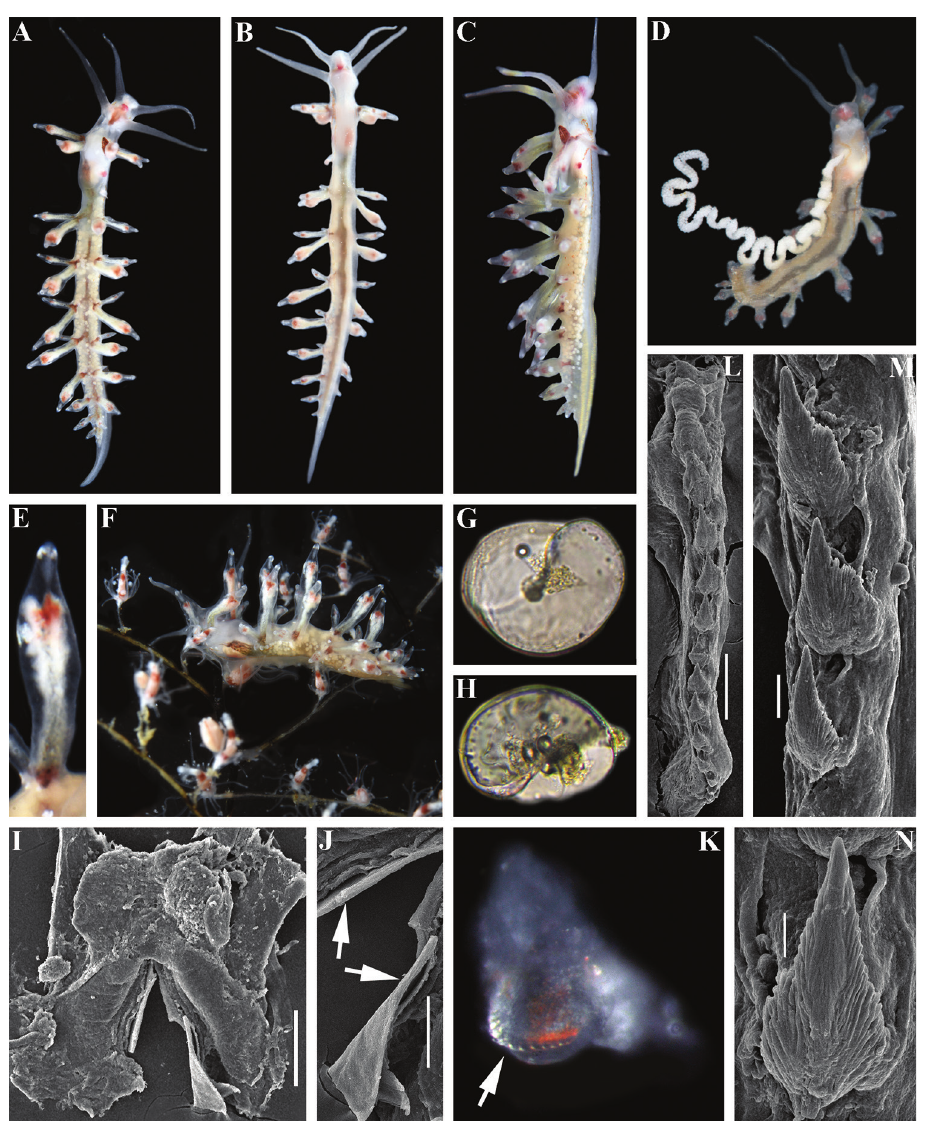
Figure 2. Myja karin sp. n. A–D holotype A dorsal view B ventral view C lateral view D animal with egg mass E details of cerata F lateral view on hydroids in situ G, H veligers; I–N paratype I jaws J smooth masticatory processes of jaws (inidicated by arrows), SEM K radula on odontophore, to show narrow teeth and reduced anteriormost teeth (arrow), LM L whole radula, SEM M teeth from the middle part of radula N anterior teeth. Scale bars: 100 μm ( I ); 50 μm ( J, L ); 10 μm ( M ); 5 μm ( N ). Photographs of living specimens by TA Korshunova and AV Martynov, SEM images by AV